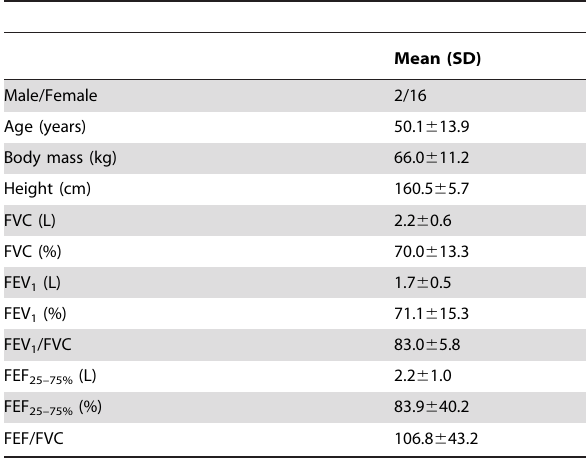
Table 7. Anthropometric characteristics of the patients studied in the analysis of expiratory flow